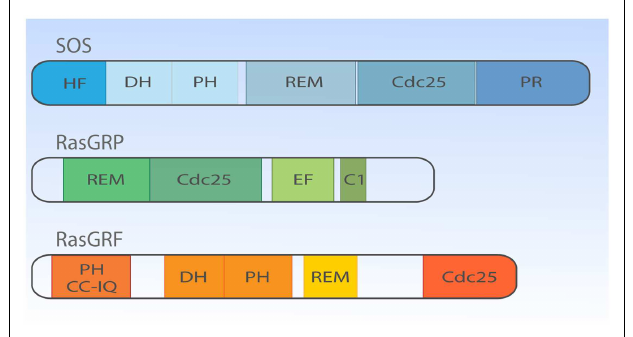
FIGURE 2 | Structural domain organization of three families of RasGEFs expressed inT cells . Cartoon highlighting the general protein domains in the three families of RasGEFs: SOS, RasGRP, and RasGRF. Cdc25, Cdc25 homology domain; DH, Dbl homology domain; HF, N-terminal histone-like fold; PH, Pleckstrin homology domain; PR, C-terminal PR domain; REM, Ras exchange motif; EF, Ca 2 + -binding EF hand; C1, DAG-binding C1 domain; CC-IQ, coiled coil – ilimaquinone domain. Protein size is drawn to approximate scale based on SOS1, RasGRP1, and RasGRF1